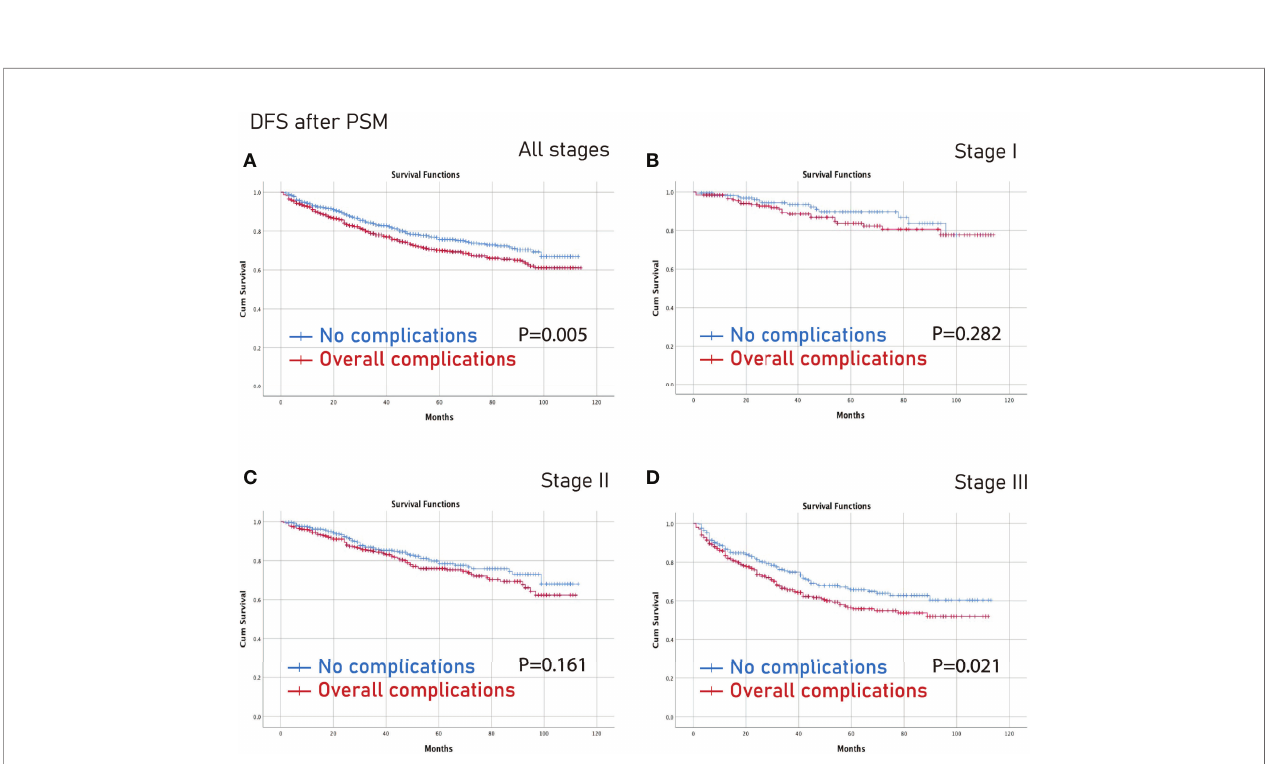
FIGURE 4 | DFS between the no complications group and the overall complications group after PSM. (A) , all stages; (B) , stage I; (C) , stage II; (D) , stage III. DFS, disease-free survival; PSM, propensity score